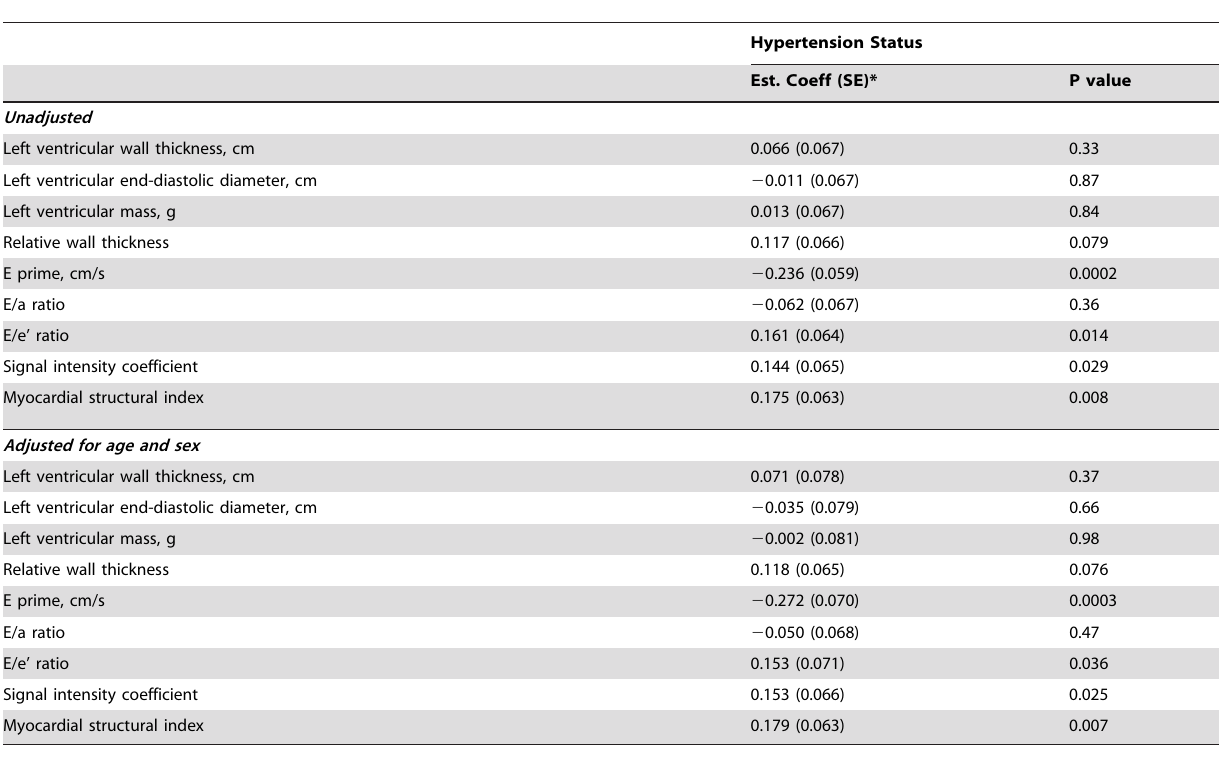
Table 2. Associations of Echocardiographic Parameters with Hypertension